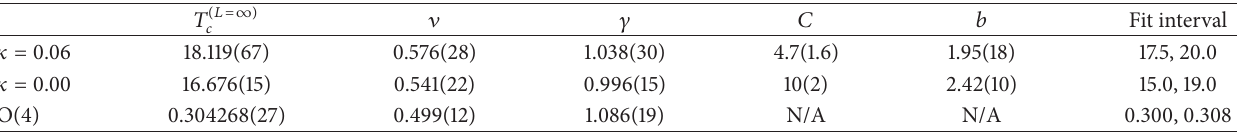
respectively. The fitted parameters extracted from (35) can